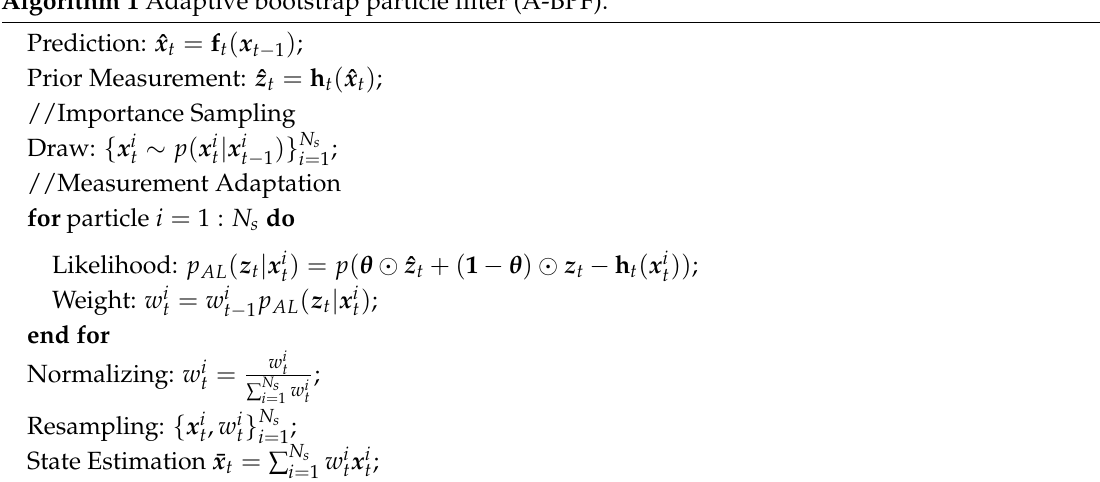
Algorithm 1 Adaptive bootstrap particle filter (A-BPF).